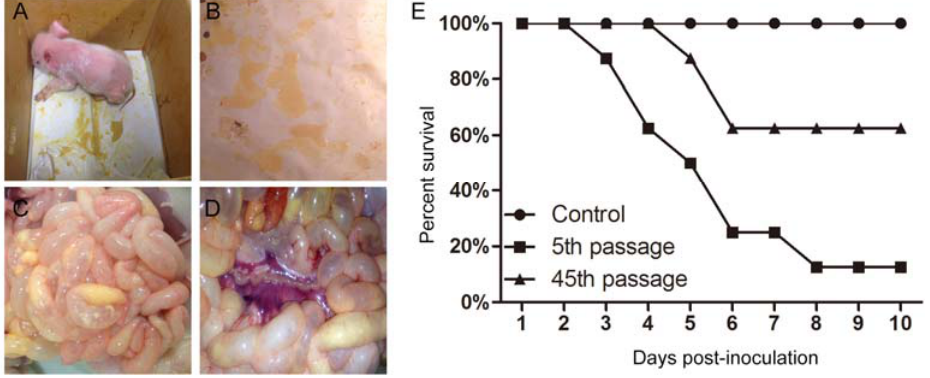
Figure 6. The clinical signs and necropsies of results of pigs infected with IEC-adapted NJ at 45th passage and the survival percentage of piglets after challenge. ( A ) Piglet with diarrhea and significantly dispirited status; ( B ) Watery diarrhea; ( C ) The intestinal tracts of infected piglets were thin and transparent; ( D ) Mesenteric congestion; ( E ) Survival percentage of piglets after challenge.